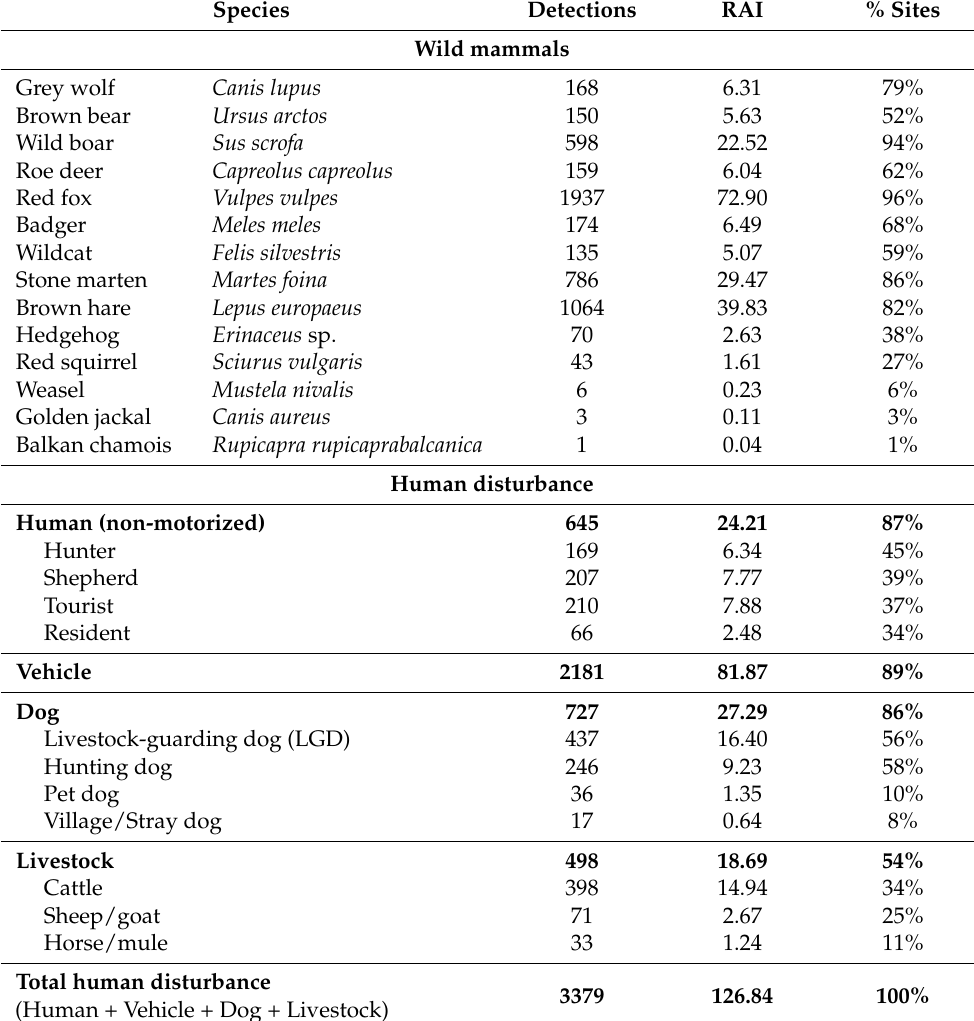
Table 1. Summary of detections, relative abundance index (RAI), and proportion of sites where each wild mammal species and human disturbance type was detected across 71 camera traps in